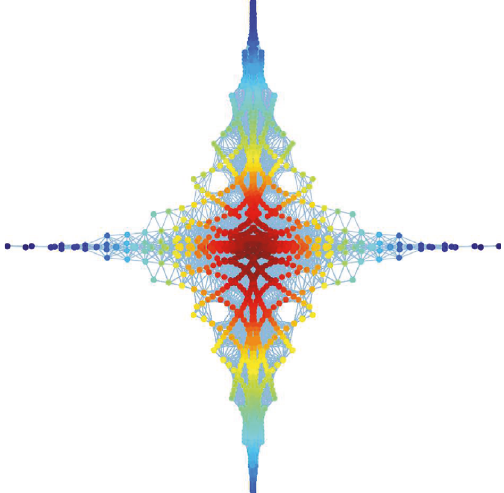
Figure 5: Spatial network constructed from the distribution of pointsinaunitsquareaccordingtothetransform 𝑇 2 usingaconnec- tion radius 𝑅 = 0.085 with 𝑛 = 1000 points and coloring the nodes according to their closeness centrality.